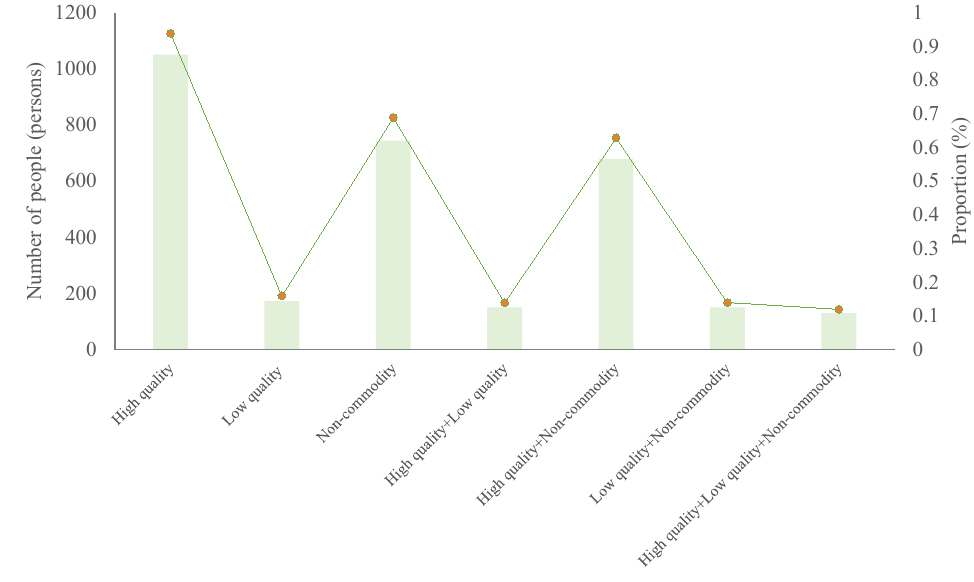
Figure 2. Energy consumption structure.